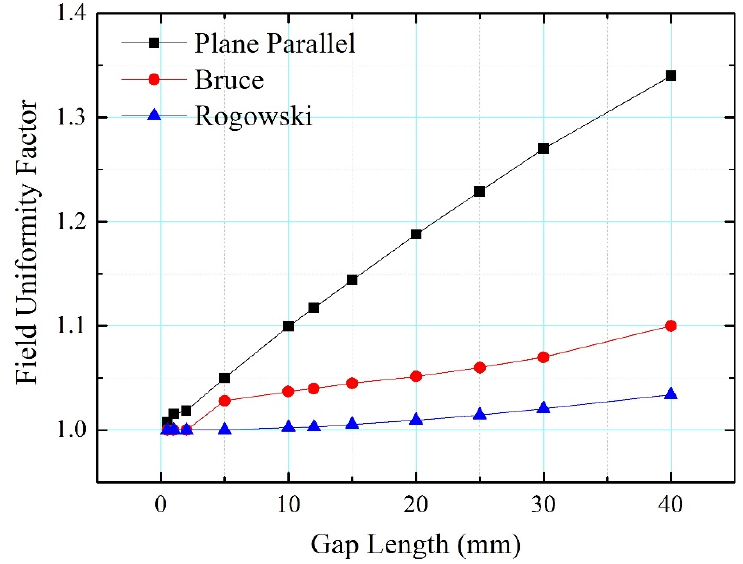
Figure 8. η versus gap length d for different electrode profiles.